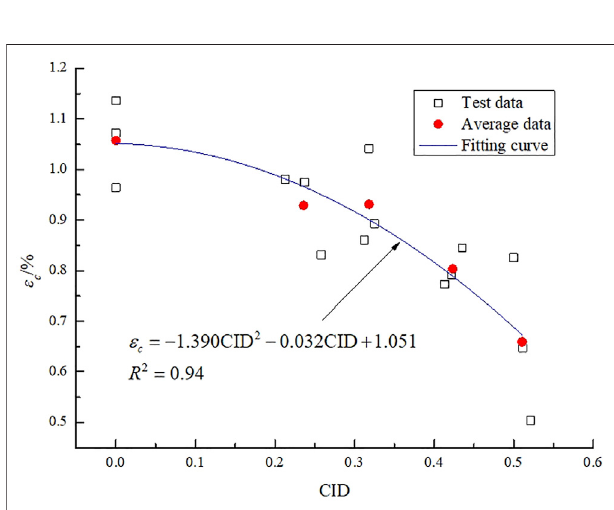
FIGURE 7 | Relationship between the CID and the deviatoric stress of the coal sample.